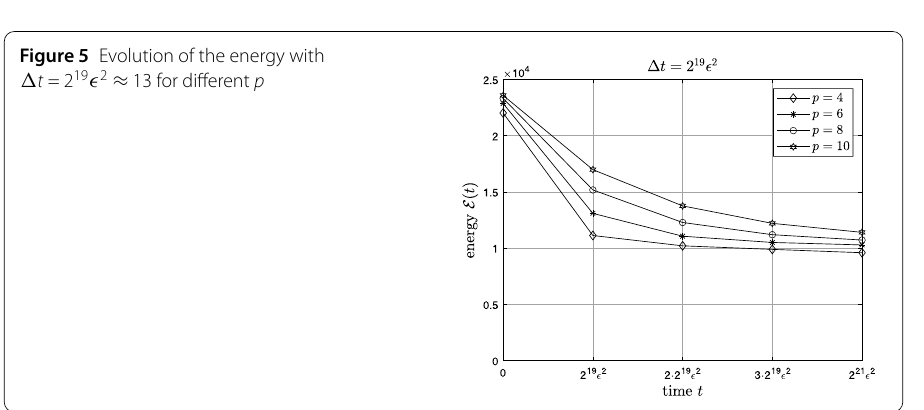
Figure 4 Evolution of the energy with different time steps for different p